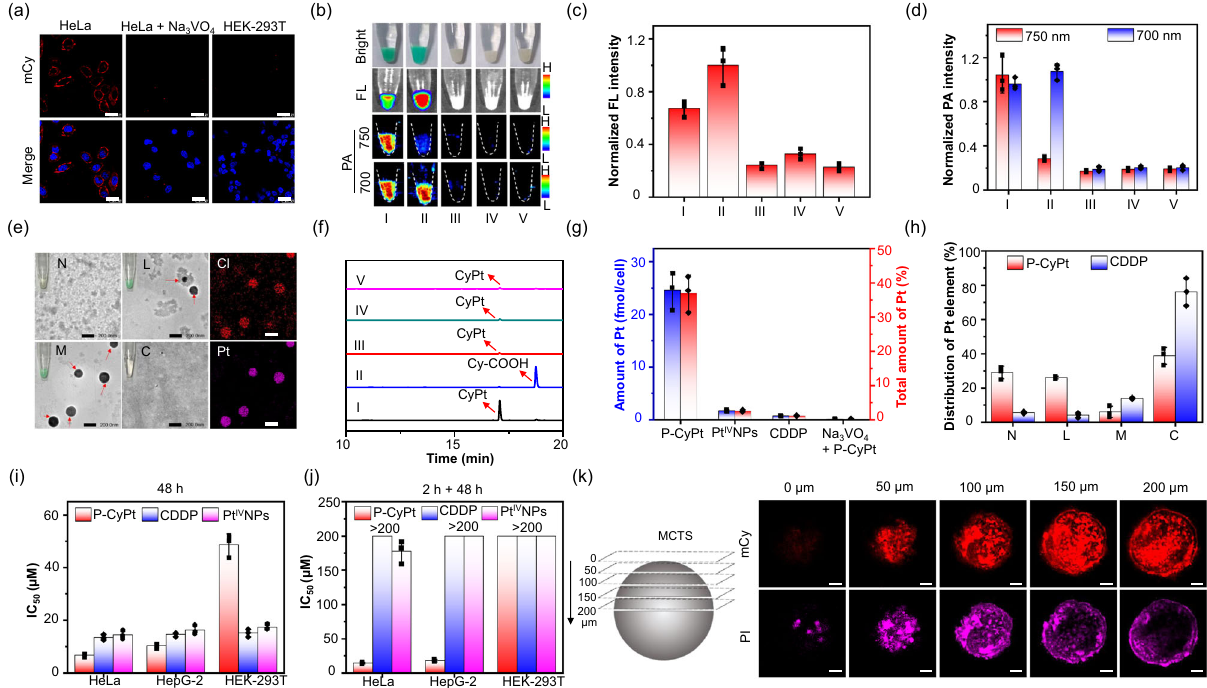
Fig.3|EvaluationofP-CyPtincells.a FLimagingofHeLacells,Na 3 VO 4 -pretreated HeLa cells, or HEK-293T cells incubated with P-CyPt. Scale bars: 25 μ